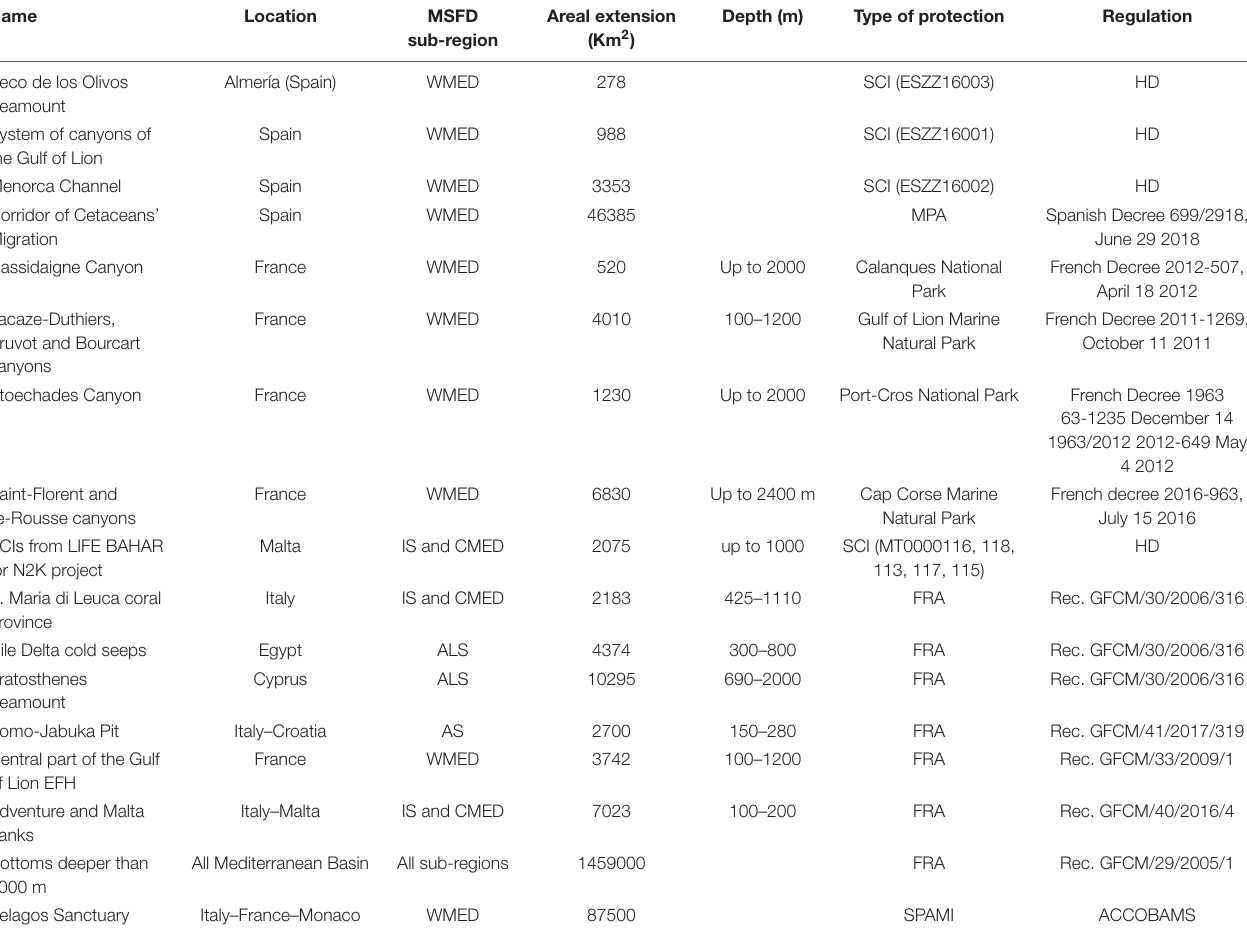
TABLE 1 | List of protected areas in the deep Mediterranean